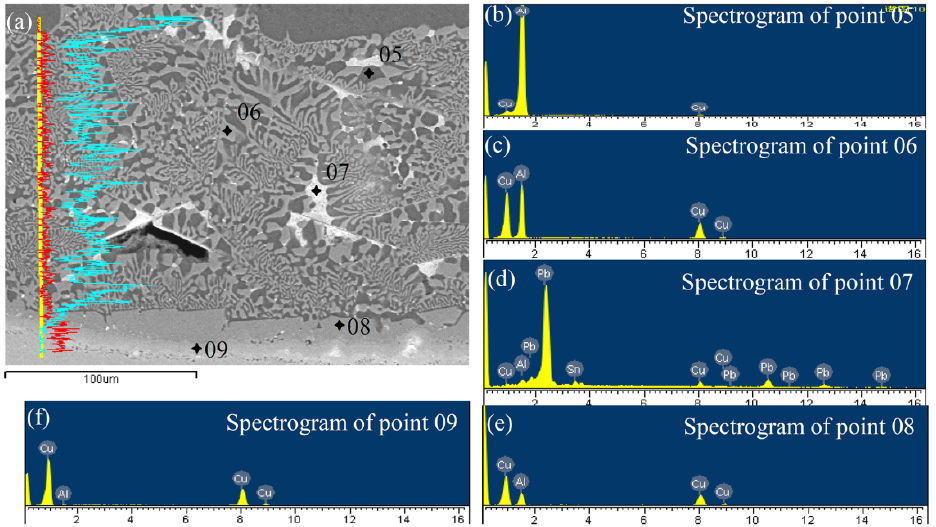
Figure 5. The distribution of elements perpendicular to the interface and the point component analysis spectrogram of the solid-liquid casting joint shown as: ( a ) the distribution of elements, ( b ) spectrogram of point 05, ( c ) spectrogram of point 06, ( d ) spectrogram of point 07, ( e ) spectrogram of point 08 and ( f ) spectrogram of point 09. Table 2. Composition analyses of the points indicated in Figure 5 (at%).